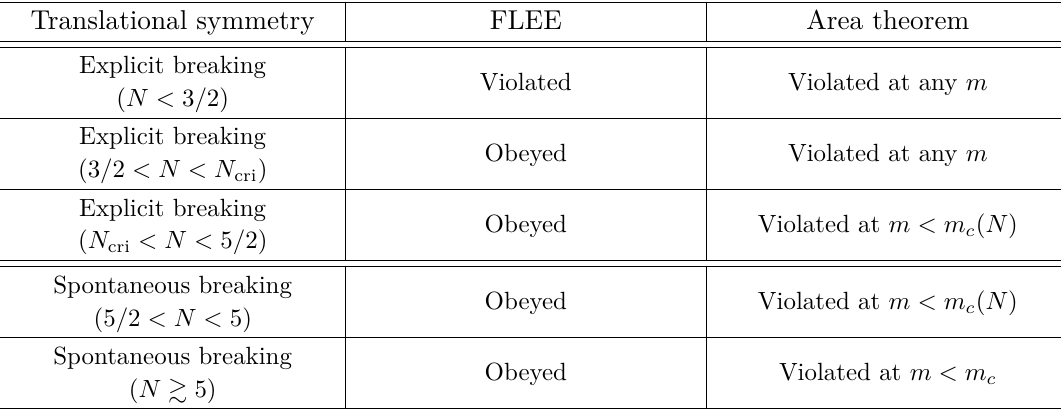
Table 2 . FLEE/area theorem with broken translation symmetry. The violation of the area theorem is examined at T = 0 and we find N cri ∼ 2 . 1